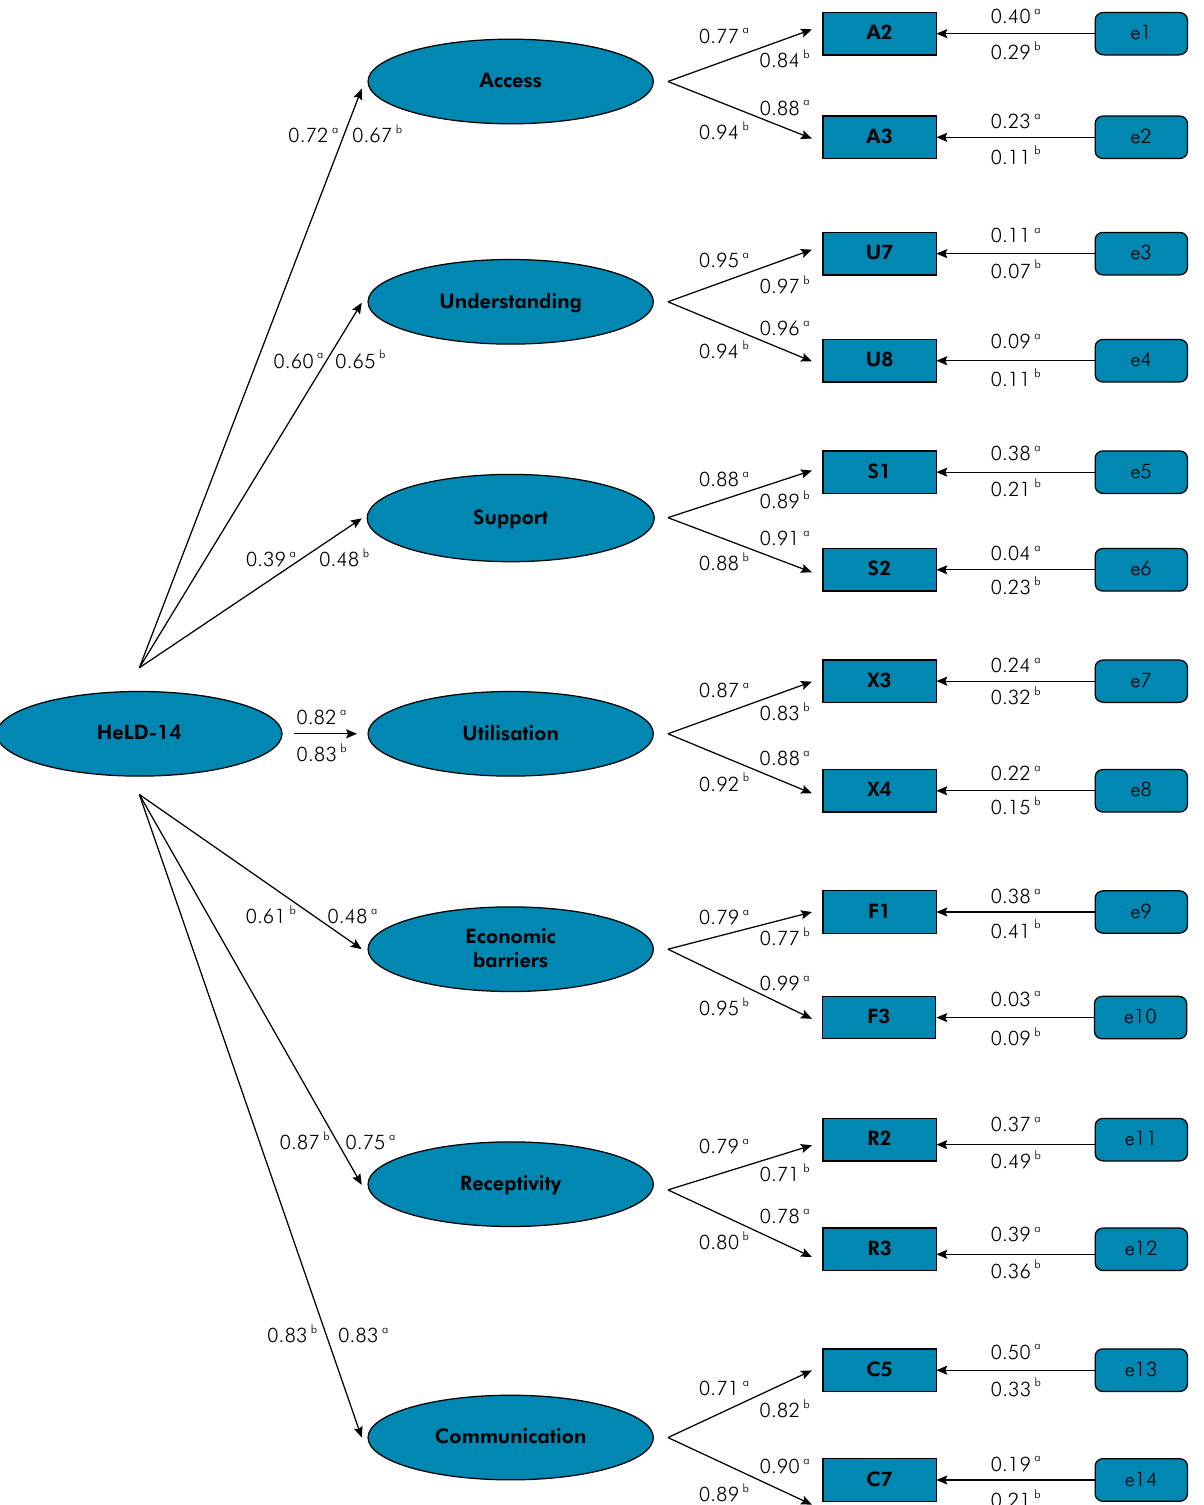
Figure. Second-order models (‘a’ and ‘b’) for the short form oral health literacy instrument